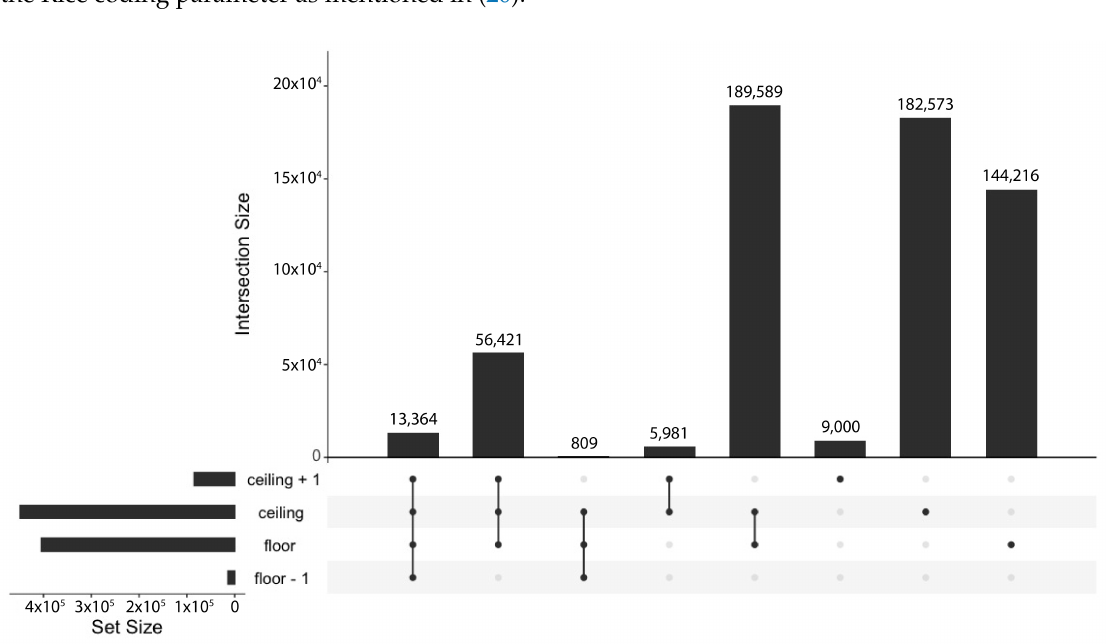
Figure 5. Number of minimal bit-length solutions found by approximating the Rice parameter as given in (20). Labels “floor”, “ceiling”, and “ceiling + 1” should be understood as (cid:98) S (cid:99) , (cid:100) S (cid:101) , and (cid:100) S (cid:101) + 1, respectively. Each column represents the number of minimal bit-length solutions obtained by using the specified approximations, e.g., there were 144,216 minimal bit-length solutions found by approximating the parameter as (cid:98) S (cid:99) and 189,589 minimal bit-length solutions found by approximating the parameter either as (cid:98) S (cid:99) or (cid:100) S (cid:101) (both are equal-cost